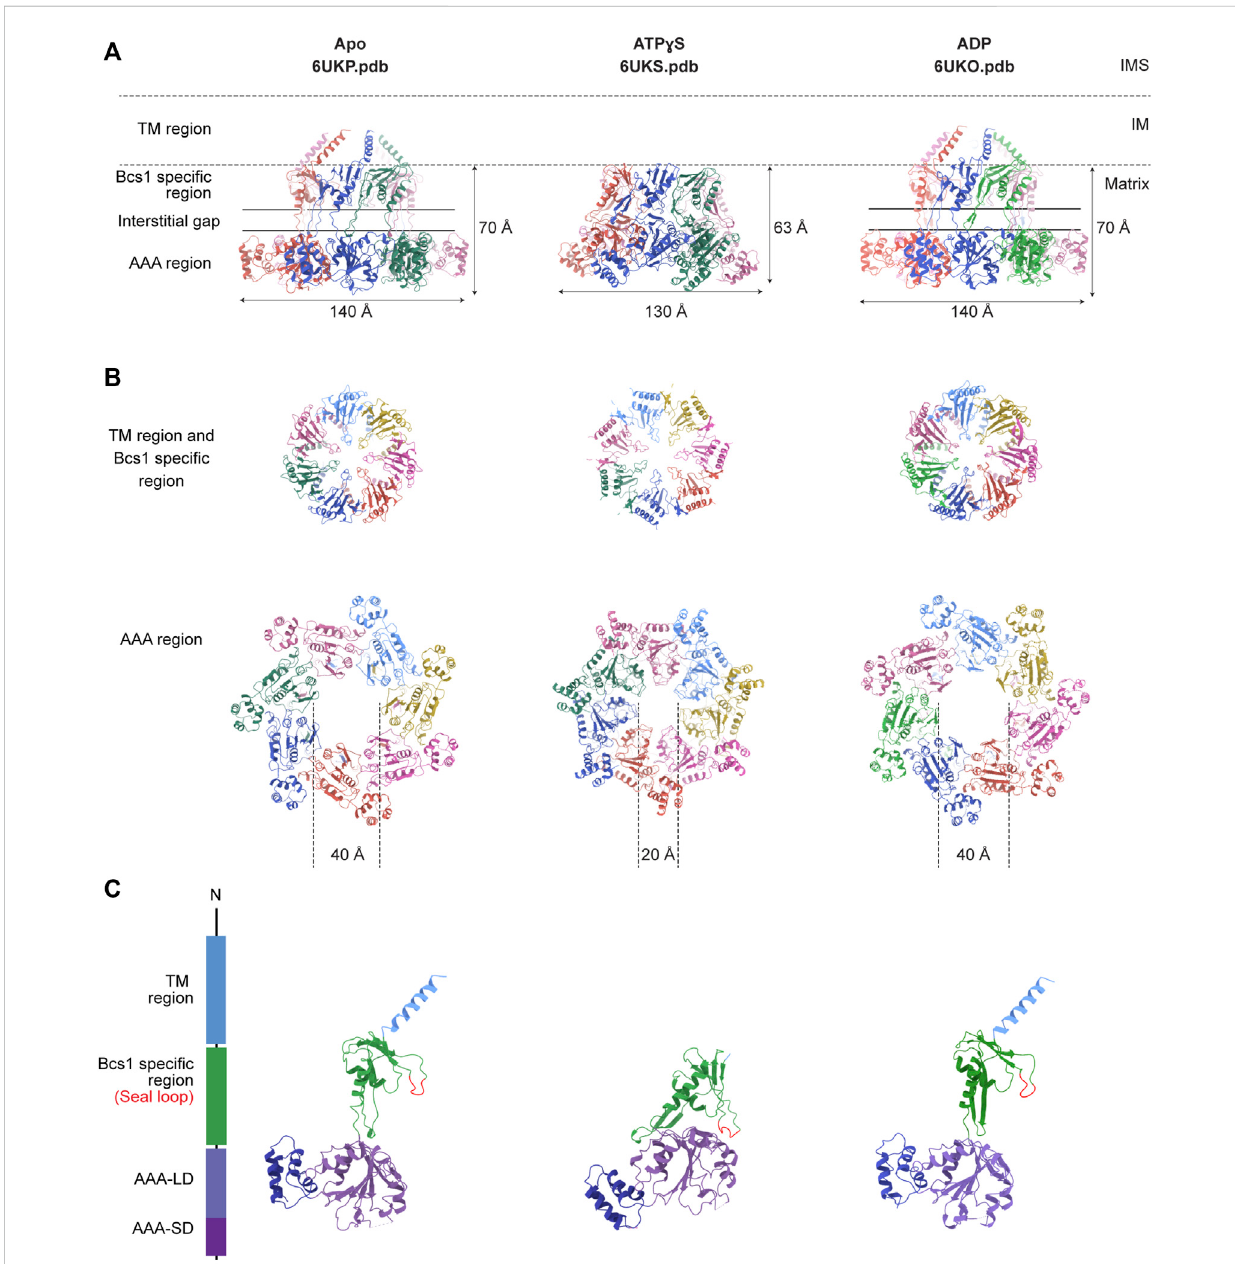
Nucleotide-dependent conformational changes of Bcs1. Ribbon diagram of mBcs1 structures determined in Apo, ATP γ S and ADP states respectively, from left to right. (A) Side view of the heptameric Bcs1 ring. (B) Top view from the matrix side of the heptameric association of Bcs1-speci fi c regionandAAAregion. (C) IsolatedBcs1protomermodelsindifferentnucleotidestateshighlightingthedomainorganization.Bcs1canbedividedintoTM region, Bcs1-speci fi cregion and theAAA region, and theAAA region can be further divided into alarge subdomain (AAA-LD) and asmall subdomain (AAA-SD). The nucleotide binding pocket lies in the interface between AAA-LD and AAA-SD.